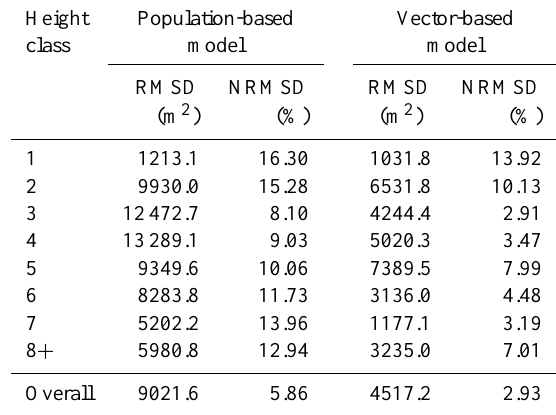
Table 4. Root mean square deviations (RMSDs) of the two models. Height Population-based